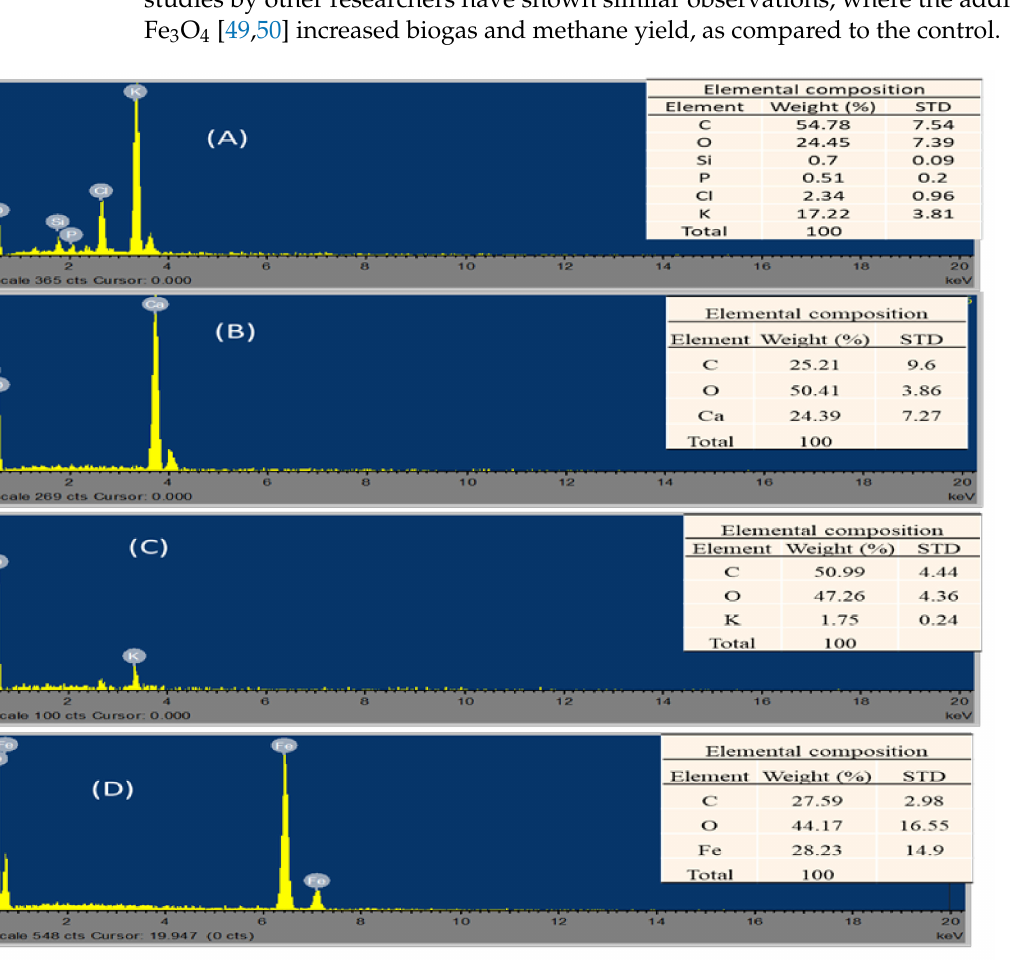
Figure 3. EDX spectrum images and tabulated elemental distribution of biomaterials with view field of 20.8 µ m at high magnification of 20 kx. ( A ) BI, ( B ) CE, ( C ) PB and ( D ) Fe 3 O 4